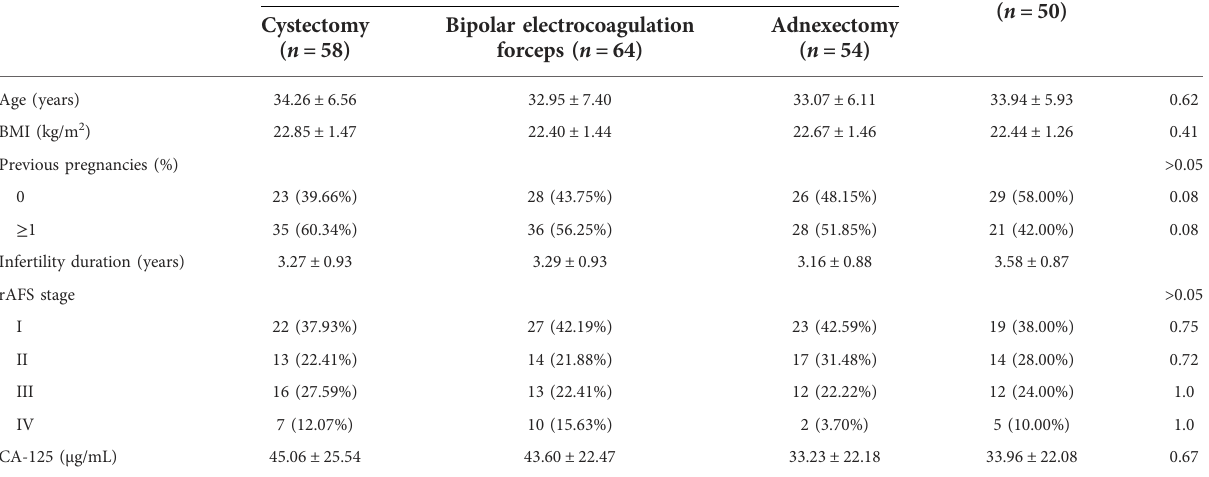
TABLE 1 Demographic features of all